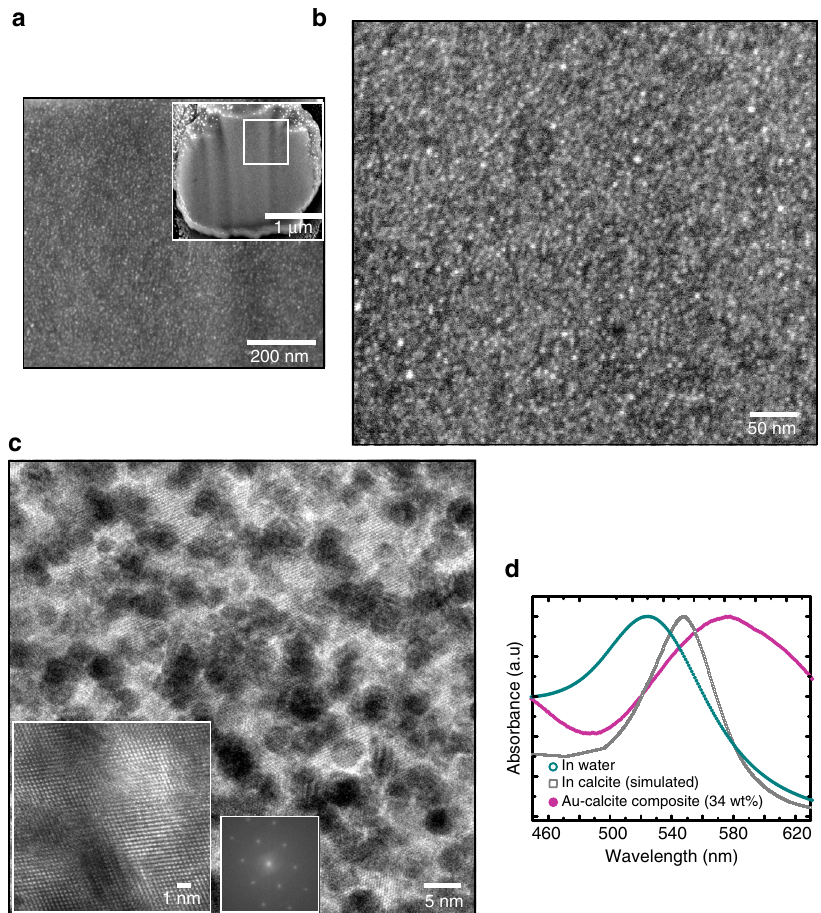
Fig. 6 Calcite single crystals containing very high densities of 4 nm PGMA-NPs. a , b SEM images of an FIB cross-section though a crystal. b is a high- magni fi cation image of a . c High-resolution bright fi eld TEM image of a cross-section through a crystal, showing lattice fringes that demonstrate single crystallinity. The inset is an FFT of the same area. d UV – Vis absorption spectra comparing 4 nm PGMA-NPs in water (green), 4 nm PGMA-NPs in calcite (simulated, grey) and 4 nm PGMA-NPs in the calcite